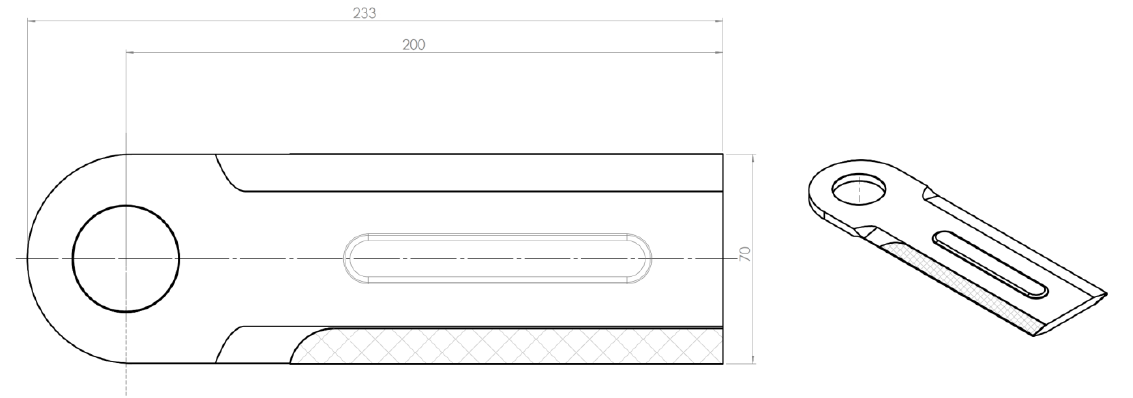
Figure A2. Structural diagram of the standard knife (Adapted with permission from Carl Geringhoff GmbH & Co. KG, 2023).